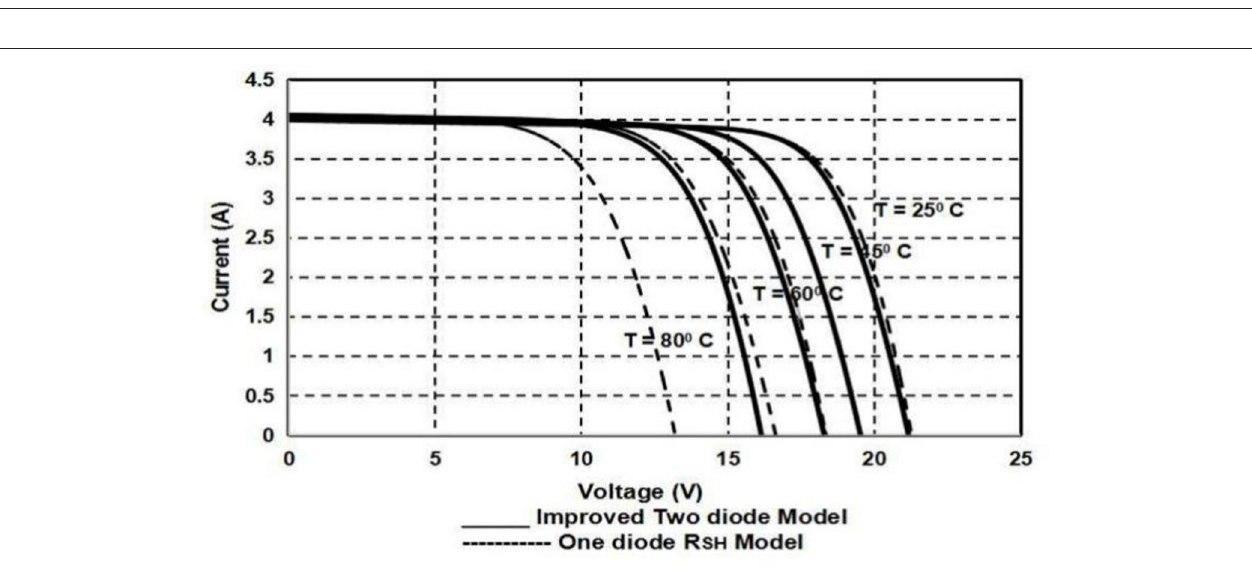
FIGURE 12 | Comparative analysis of current (A) vs. voltage (V) curve for one-diode R SH and proposed two-diode model for MSX-64 with different irradiance points at STC (25 ◦ C).